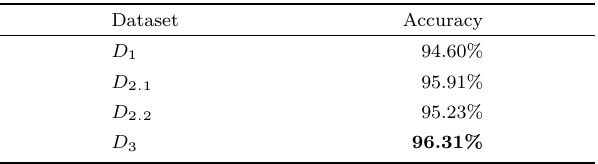
Table 5 Accuracy of the proposed fall detection system for individual datasets